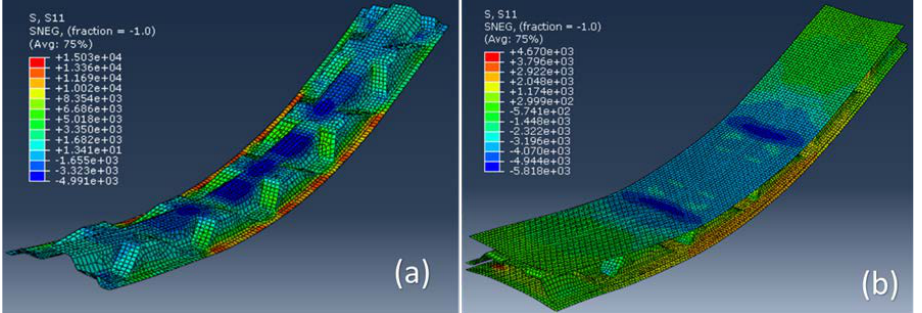
Figure 11. Deformed shape of the FE model of ( a ) 3D core and ( b ) sandwich panel.